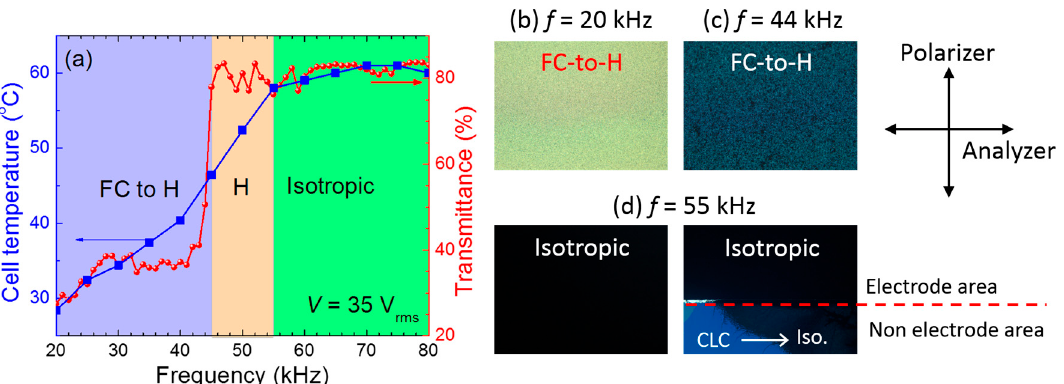
Figure 2. ( a ) Frequency-dependent cell temperature and transmission of the CLC cell driven by a square-voltage at V = 35 V rms and the corresponding optical textures at ( b ) f = 20 kHz, ( c ) f = 44